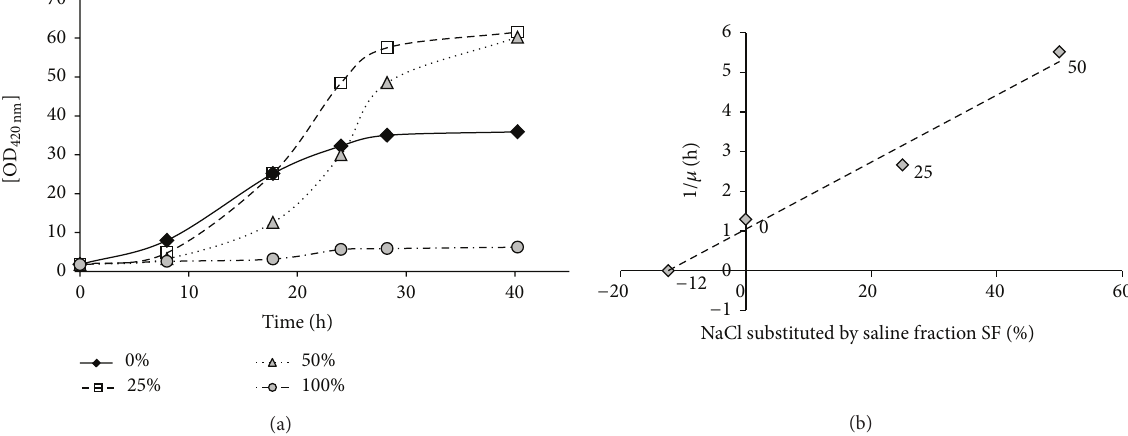
Figure 4: (a) Time curves of optical density: different percentages of NaCl in H. mediterranei DSM 1411 medium replaced by saline fraction “SD” from product isolation. (b) Dixon plot for evaluation of the inhibiting amount of saline fraction.